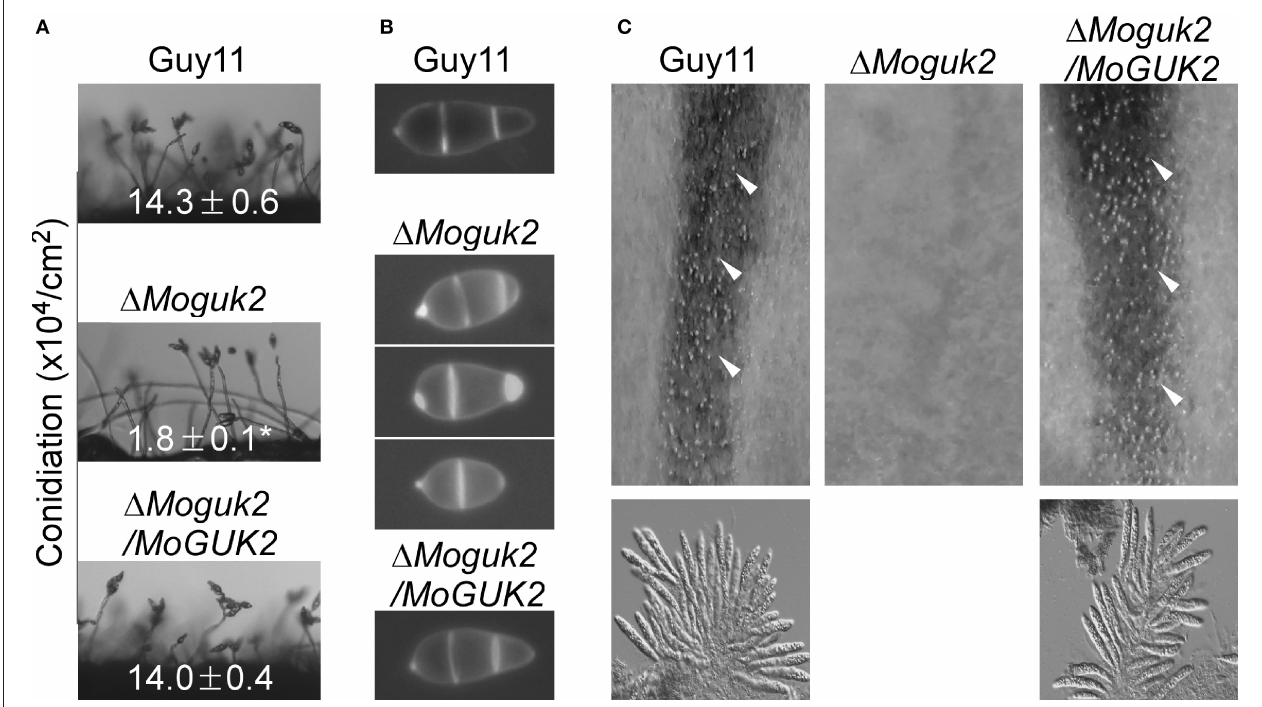
FIGURE 4 | The 1 Moguk2 mutant showed defects in asexual and sexual development. (A) Conidial development was examined under a light microscope 20 h after induction on glass slides. ± SD was calculated from three repeated and asterisks represent significant differences at P < 0.01. (B) Conidial morphology of the 1 Moguk2 mutant. (C) Perithecia and asci formed by the indicated strains were photographed 3 weeks after inoculation. White arrows indicate peritheria.